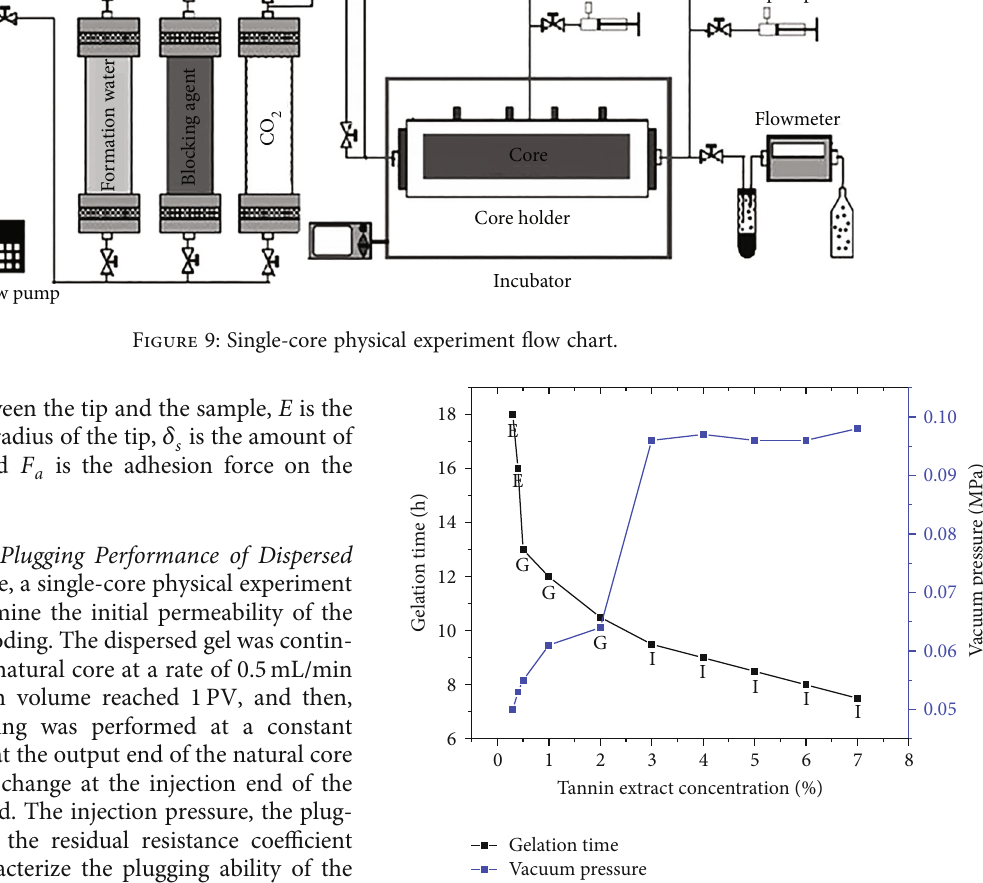
Figure 10: The e ff ect of tannin concentration on the gel formation and strength of the